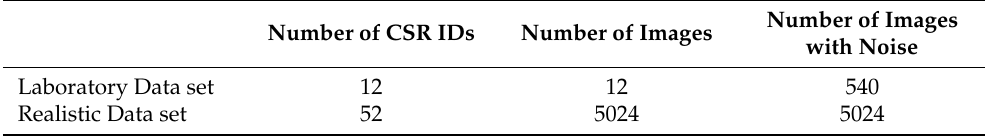
Table 3. Generated dataset for CSR responses acquired from different